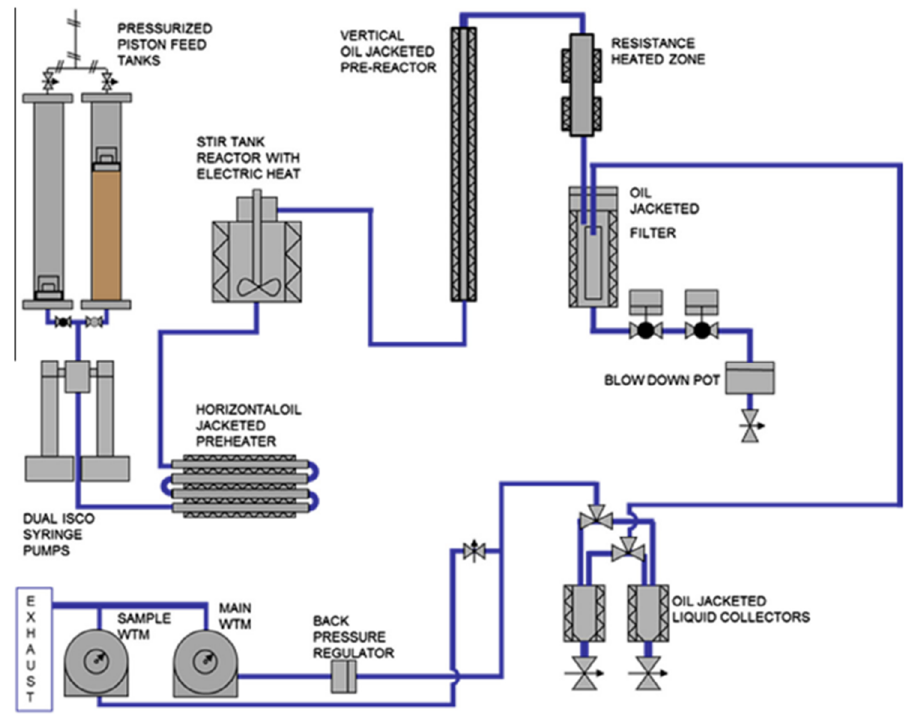
Figure 3. Process scheme of the plant in Pacific Northwest National Laboratories, adopted from